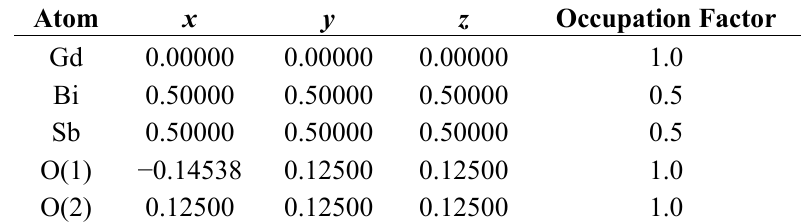
Table 2. Structural parameters of Gd 2 BiSbO 7 prepared by solid-state reaction method. x , y and z refer to the position coordinates of different atoms in one unit cell, respectively.